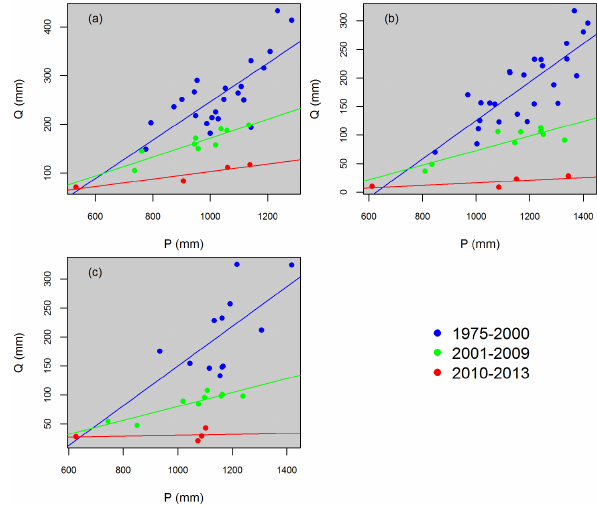
Figure 1. Annual Q ∼ P relationships for three catchments in SWA. Catchments shown are: (a) Waterfall Gully (9km 2 ), (b) Del Park (2km 2 ), and (c) Bates (2km 2